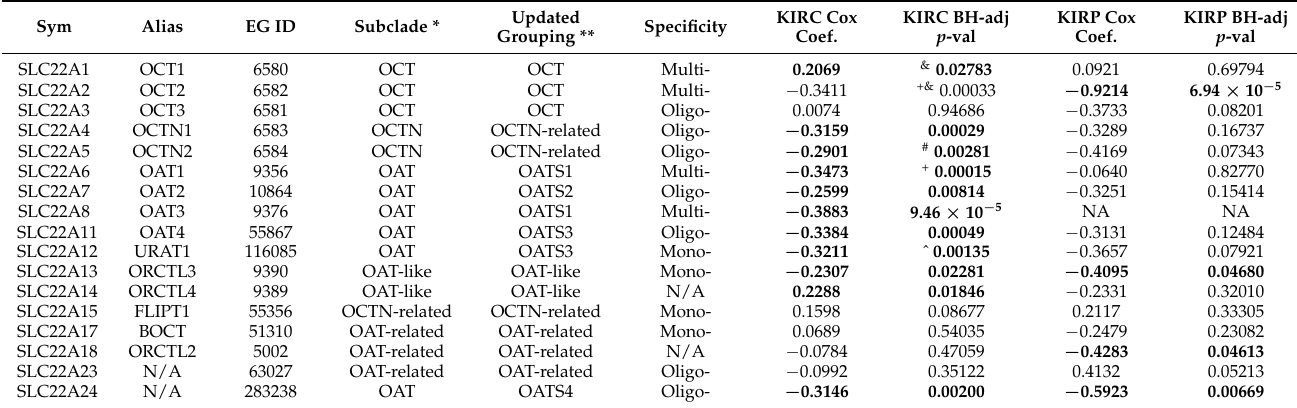
Table 2. SLC22 gene annotation and OncoLnc survival analysis